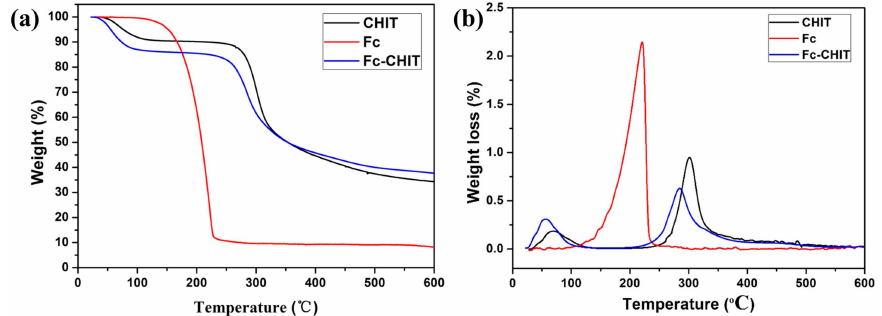
Figure 2. Thermogravimetric analysis before and after Fc-modified chitosan; ( a ) TGA, ( b ) DTG. Microstructural morphology of Fc-CHIT / CNT@Cu composites are characterized and shown